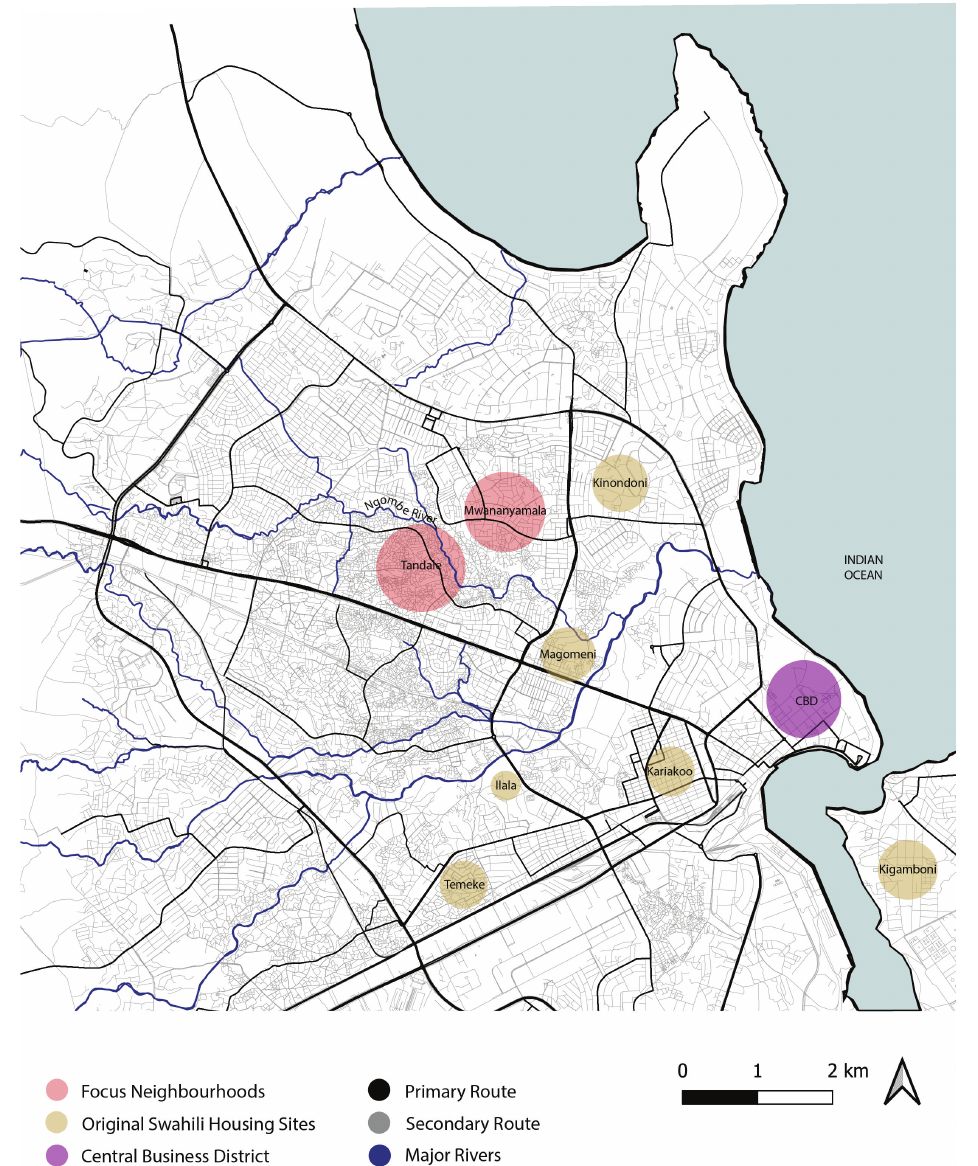
Figure 1. Dar es Salaam’s urban area and location of case study areas. Source: Courtesy of Lerys Hendricks. participation in housing low‐income dwellers came